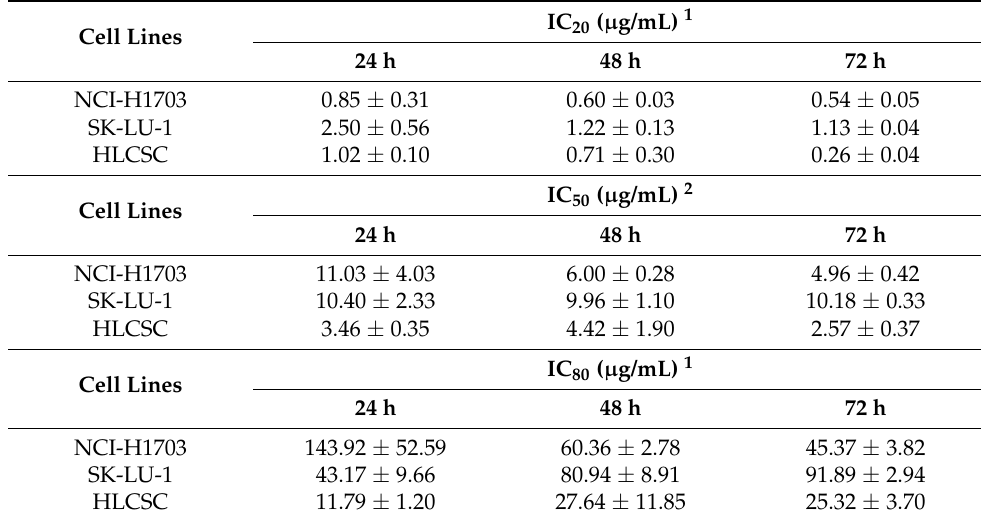
Table 5. IC 20 , IC 50 and IC 80 values of